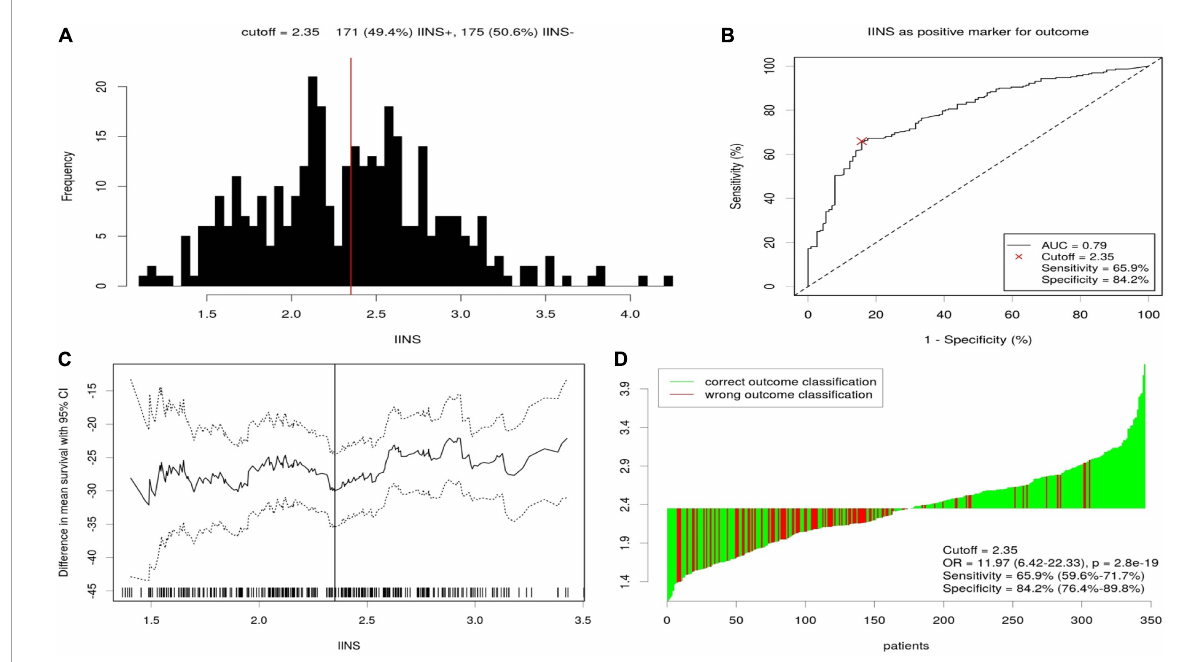
FIGURE4 The optimal cutoff value achieved for integrative inflammatory and nutritional score (IINS). Distribution for IINS based cutoff optimization (A) . A score of 2.35 was chosen as the optimal cutoff point by receiver operating characteristic (ROC) (B) . Cutoff optimization by correlation with cancer-specific survival (CSS) prediction (C) . Waterfall plot for IINS (D) .